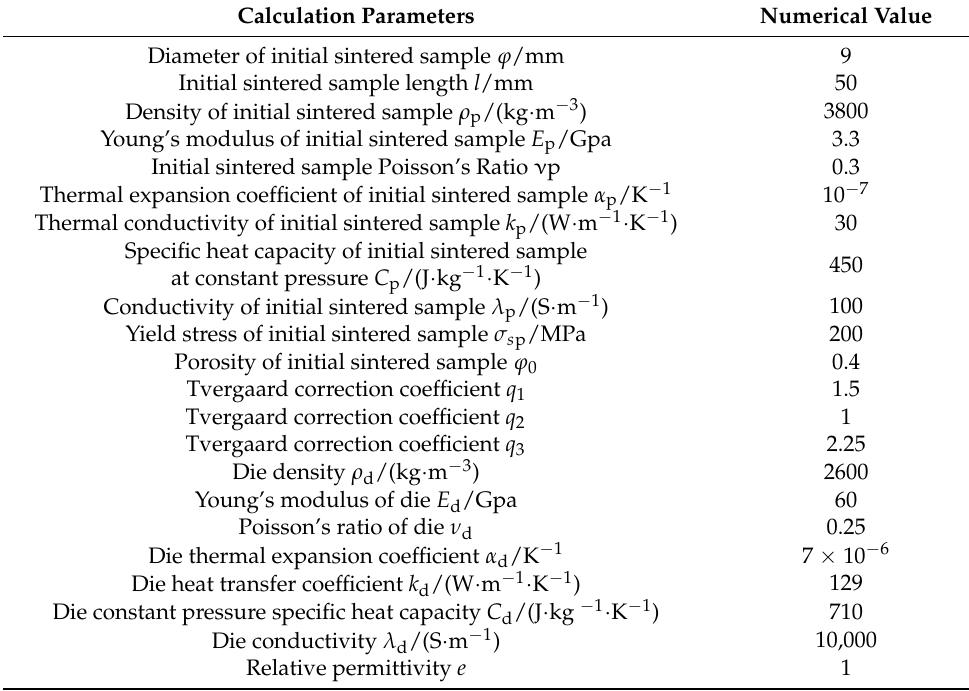
Table 1. Numerical simulation parameters of electric field-assisted sintering of Inconel